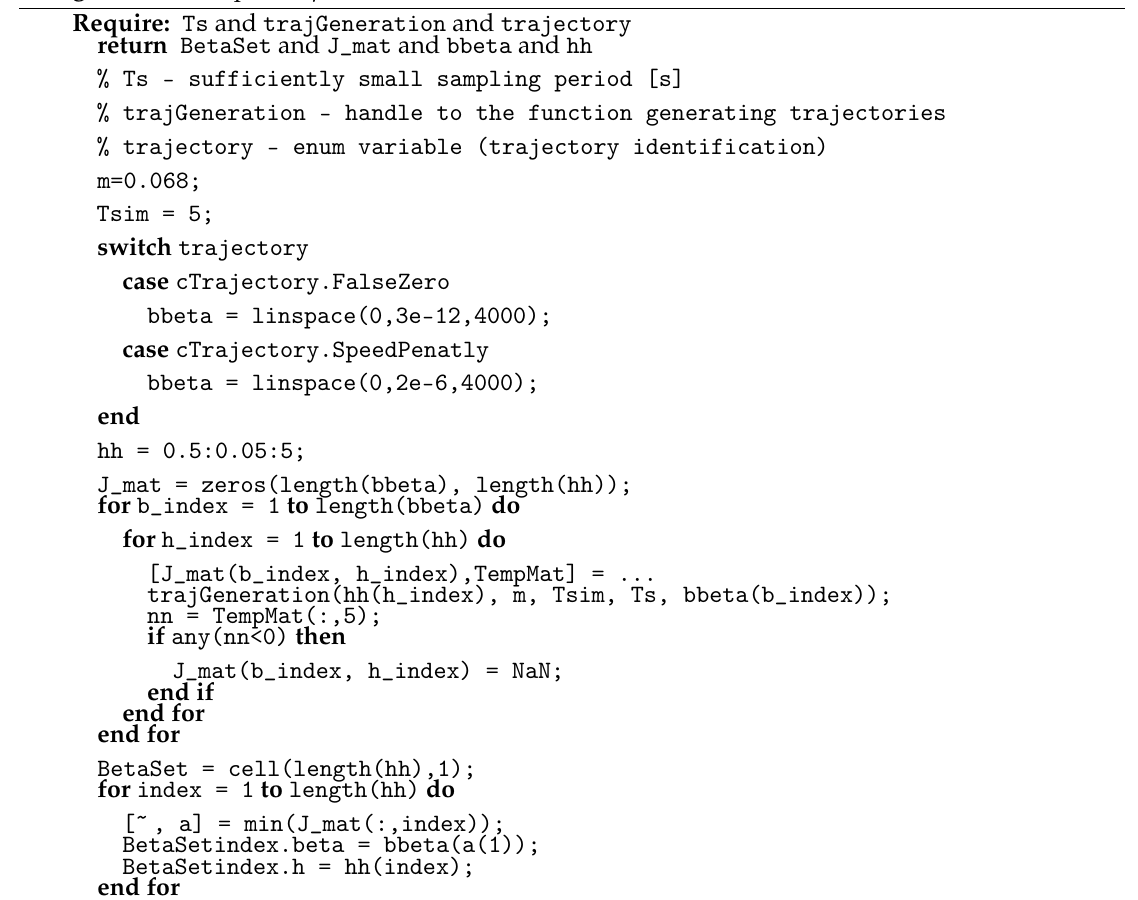
Algorithm A1: Optimal β